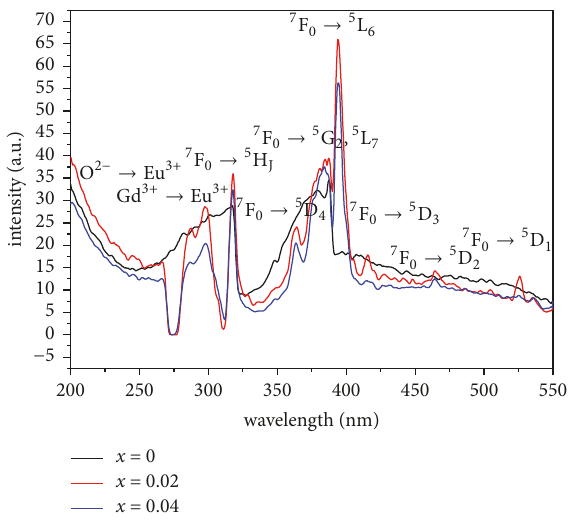
Figure12:Emissionspectrawith 𝜆 (x=0, 0.02 and 0.04) at 300